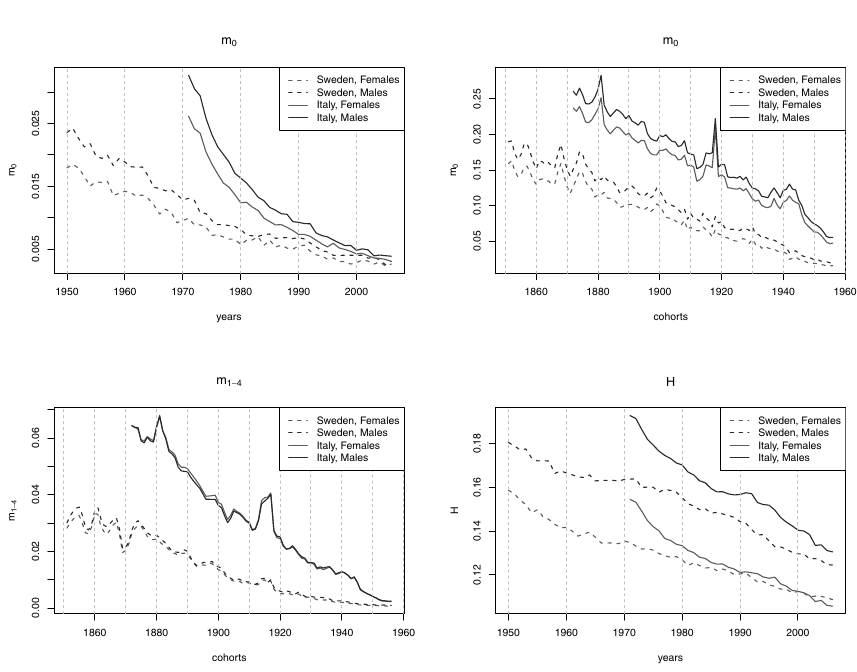
Figure 2 – Period and cohort indicators. Infant mortality ( m 0 ) over years and cohorts (top panels). Child mortality ( m 1-4 ) over cohorts (bottom-left panel), entropy measure ( H ) over years (bottom- right panel). Sweden and Italy, both